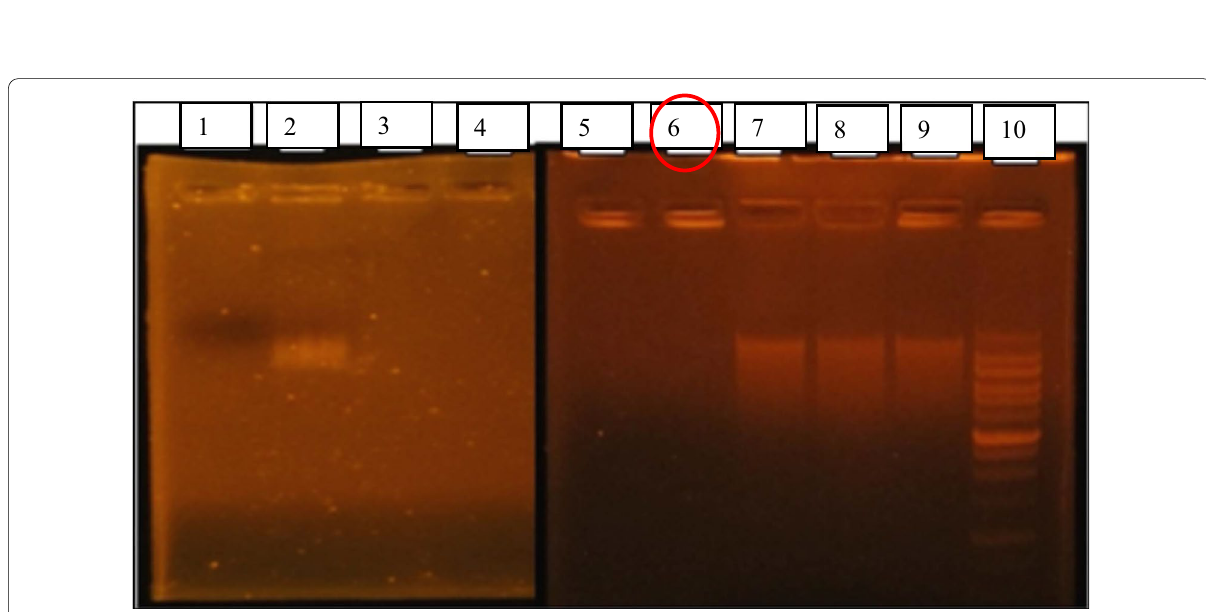
Fig. 4 Gel images of DNA showing; (1) Negative control; (2) Positive control; (3) 150 °C; (4) 120 °C; (5) 100 °C; (6) 90 °C; (7) 80 °C; (8) 60 °C; (9) 40 °C; (10) Marker. The gDNA was degraded at 90